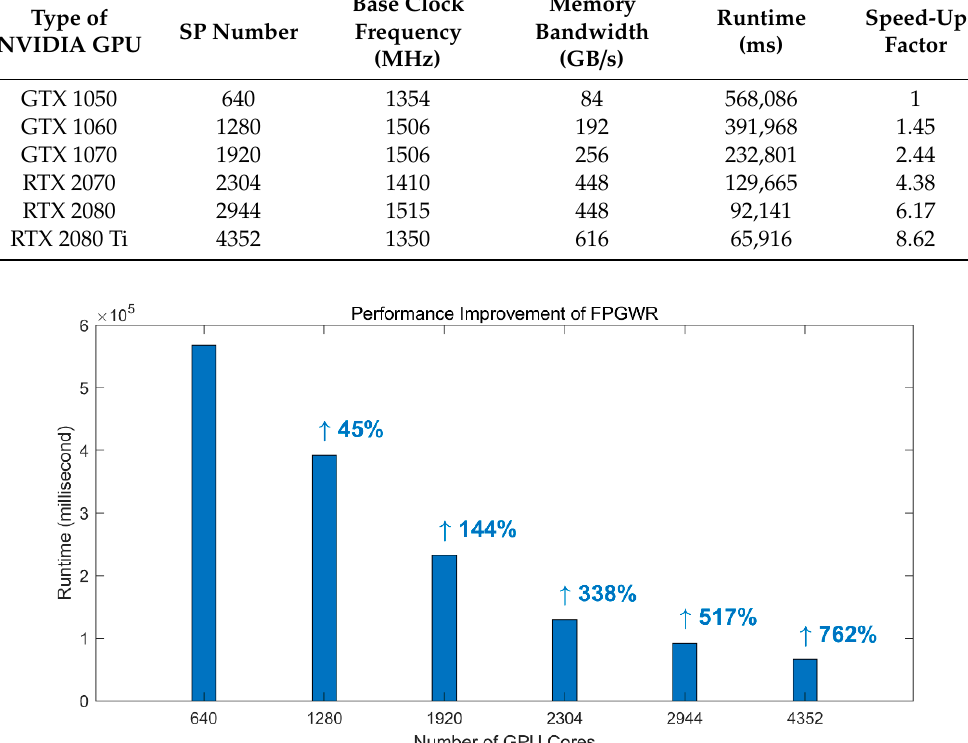
Figure 5. Performance comparison of FPGWR for an increasing number of GPU cores.